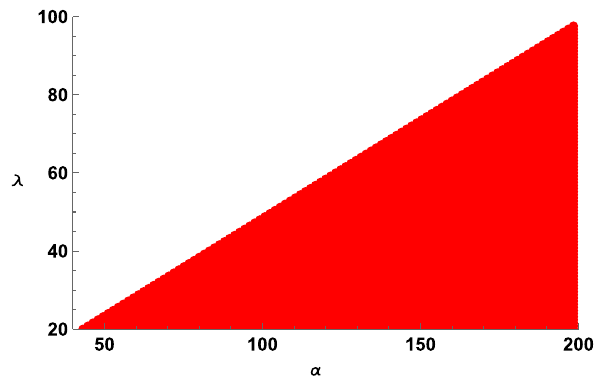
Fig. 1 The figure describes a region in the phase space structure where theAcosmologicalsolutionissaddle,inthecasewhere w m = − 0 . 0001